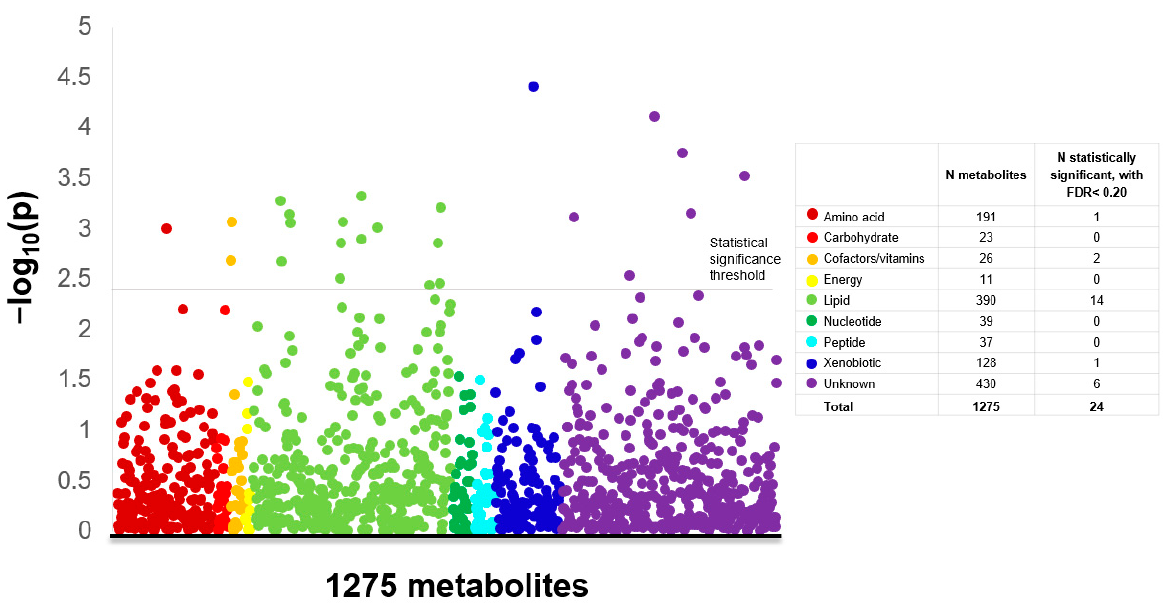
Figure 1. Manhattan plot displaying the p -values for metabolite-breast cancer risk associations from conditional logistic models, separated by chemical class. For each chemical class, the key shows the total number of metabolites and the number with statistically significant associations (false discovery rate <0.20). Models were adjusted for age at blood draw.